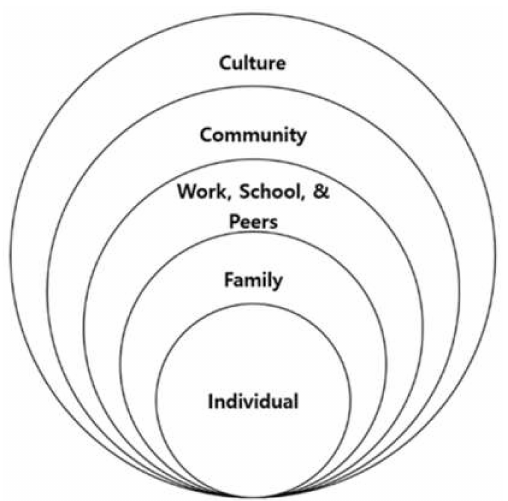
Figure 1. Modified socioecological systems theory (adapted from Bronfenbrenner, 1994